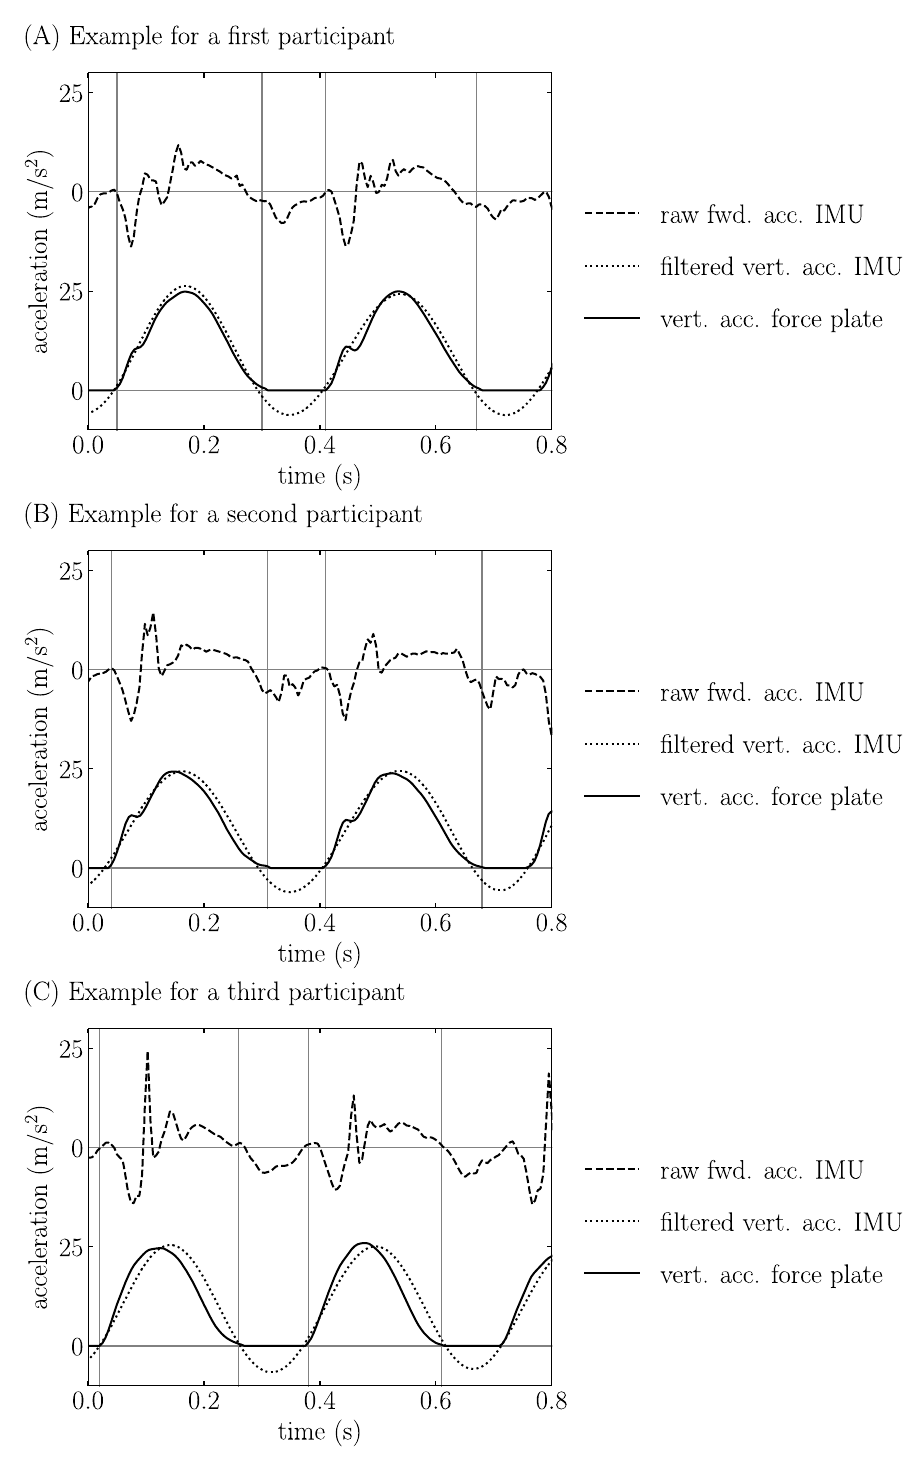
Figure 1. Raw forward acceleration from inertial measurement unit (IMU), filtered vertical acceleration from IMU, and vertical acceleration from force plate during a running stride for three representative participants at 11 km/h are reported in ( A – C ). The vertical lines represent foot-strike and toe-off events as determined using a 20 N threshold on force plate data.